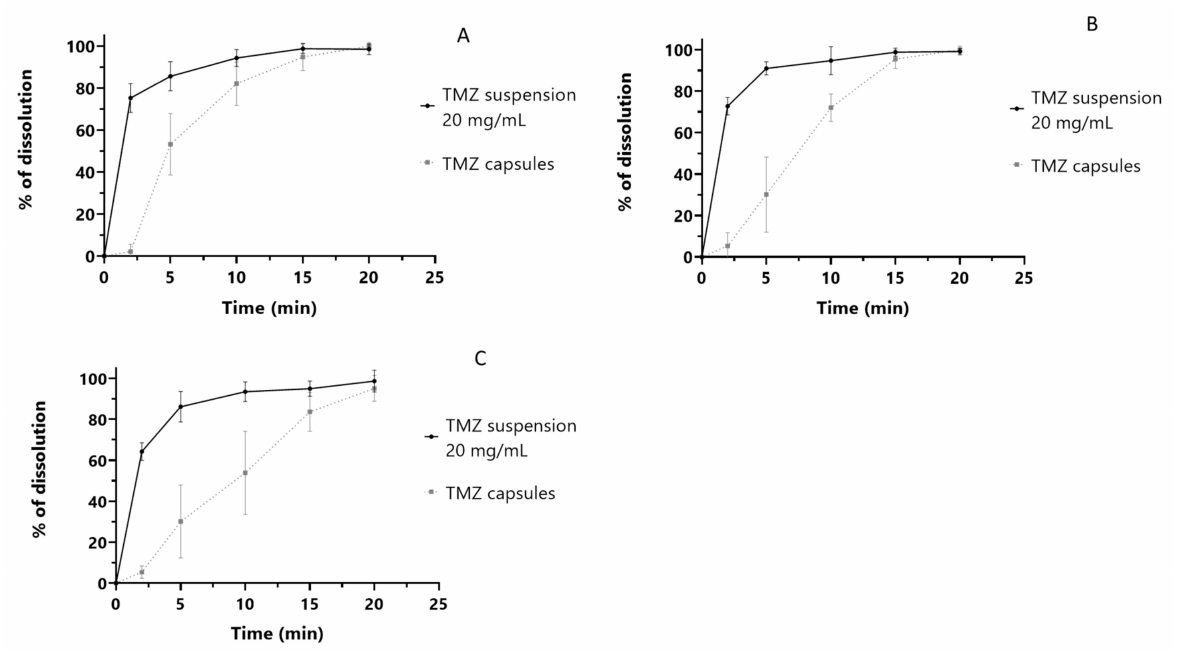
Figure 3. In vitro dissolution profiles of TMZ suspension and capsules, ( A ) dissolution in buffer at pH 1.2; ( B ) at pH 4.5 and ( C ) at pH